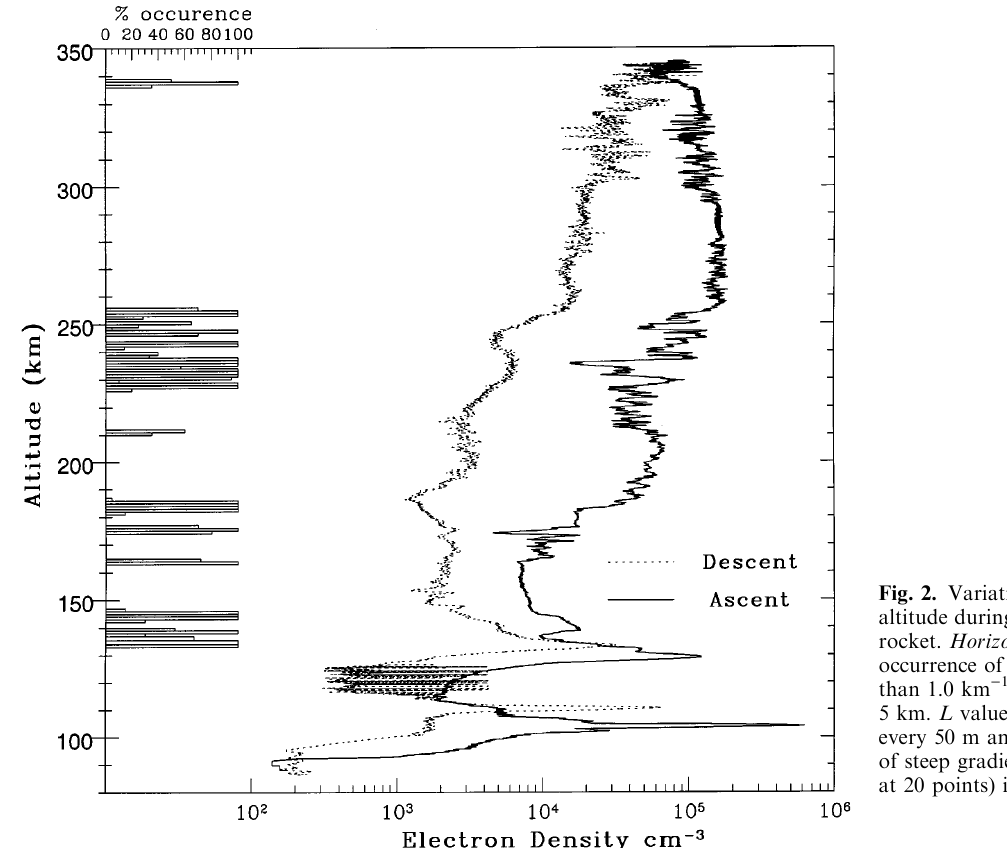
Fig. 2. Variation of electron density with altitude during the ascent and descent of the rocket. Horizontal bars show the percentage occurrence of steep gradients ( L (cid:255) 1 smaller than 1.0 km ) 1 ) over a vertical extent of 5 km. L values (over 5 km) were obtained every 50 m and the frequency of occurrence of steep gradients in every 1 km interval (or at 20 points)